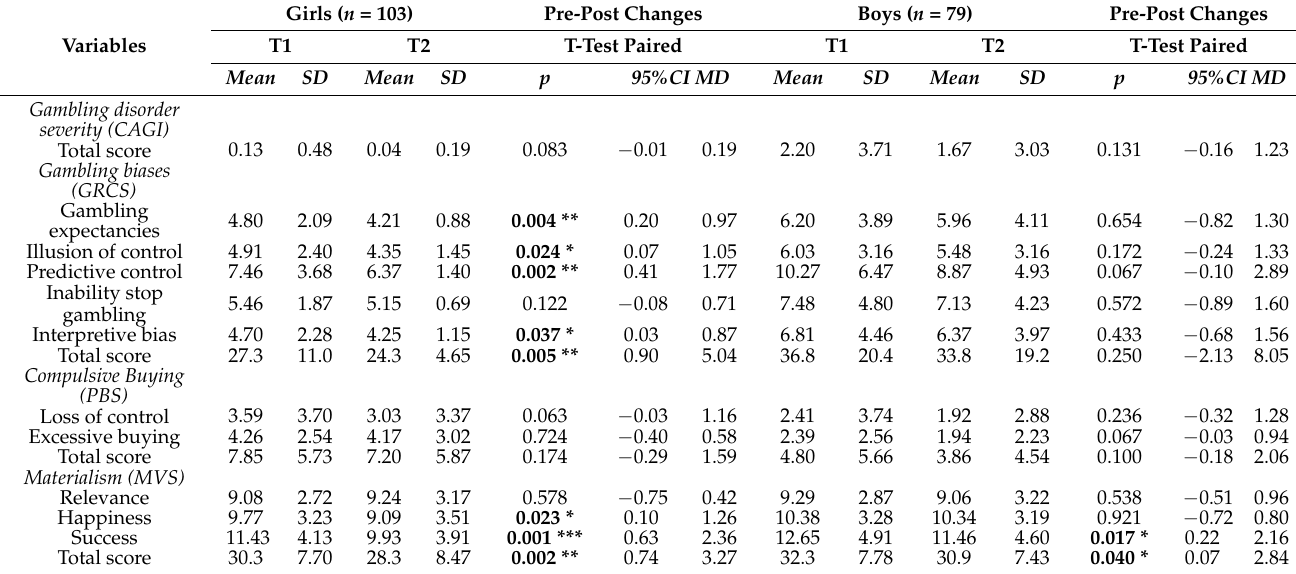
Table 2. Changes between Time 1 and Time 2 for the measures of the study, stratified by gender.